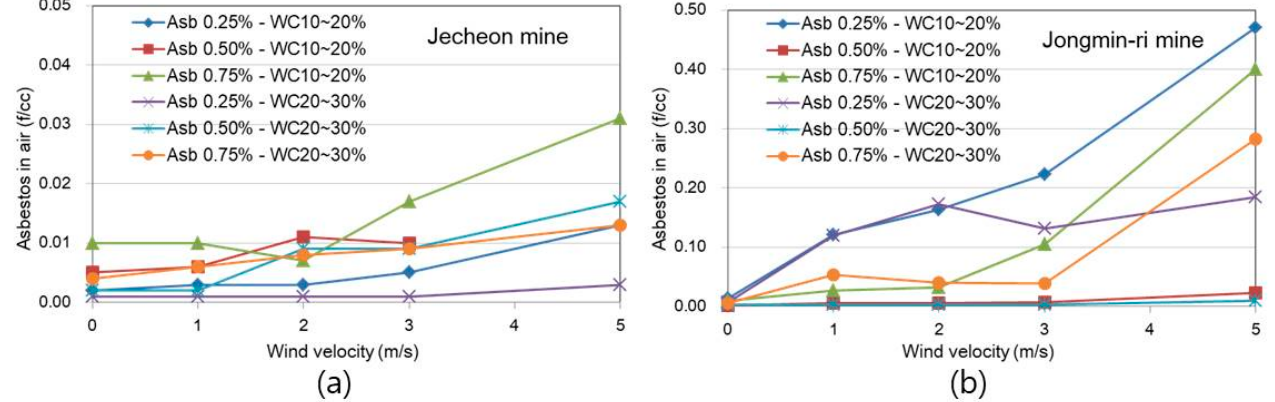
Figure 3. Asbestos contents in the air with asbestos contents in soils (Abs with 0.25%, 0.50%, and 0.75%), wind velocity (0, 1, 2, 3, and 5 m/s), and water contents in soils (WC of 10~20% and 20~30%) controlled by the modified RAS equipment adopted in the Jecheon mine ( a ) and the Jongmin-ri mine ( b ) areas.